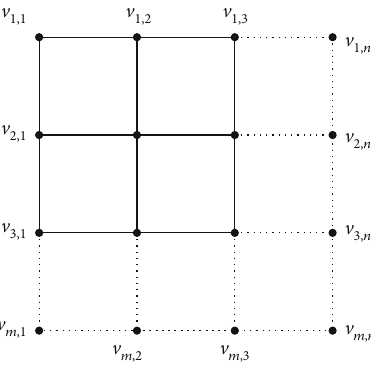
Figure 1: Representation of superior vertex